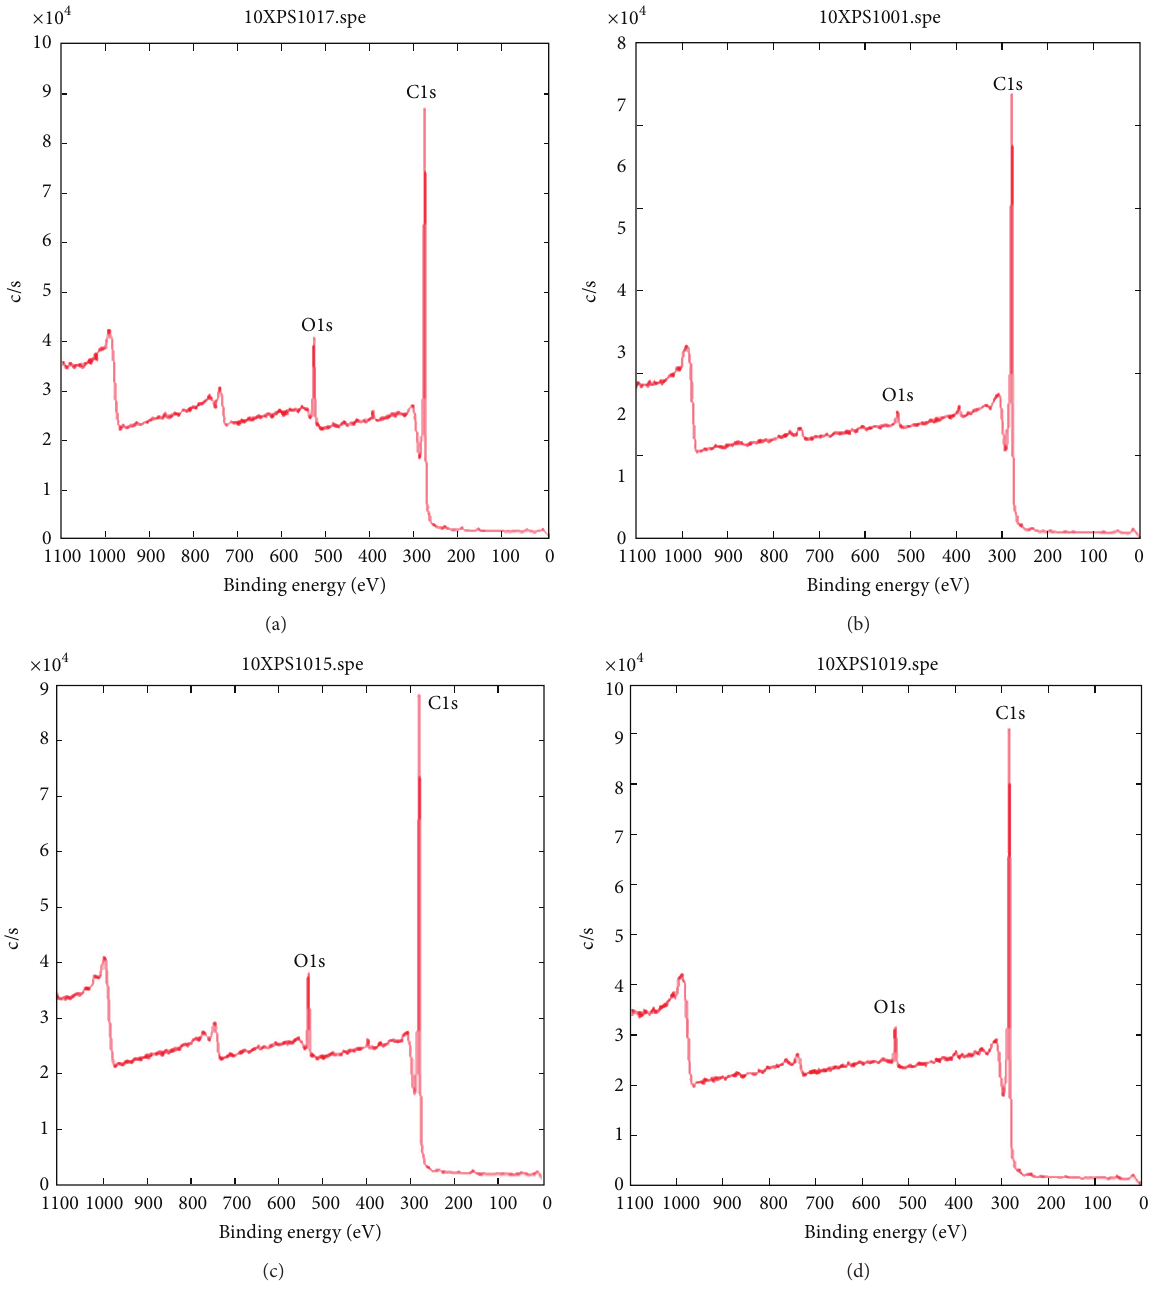
Figure 3: XPS elemental scan of GNPs. (a) GNPs; (b) GNPs annealed without exposure to air; (c) GNPs annealed then exposed to air; (d) GNPs annealed then hydrogenated.